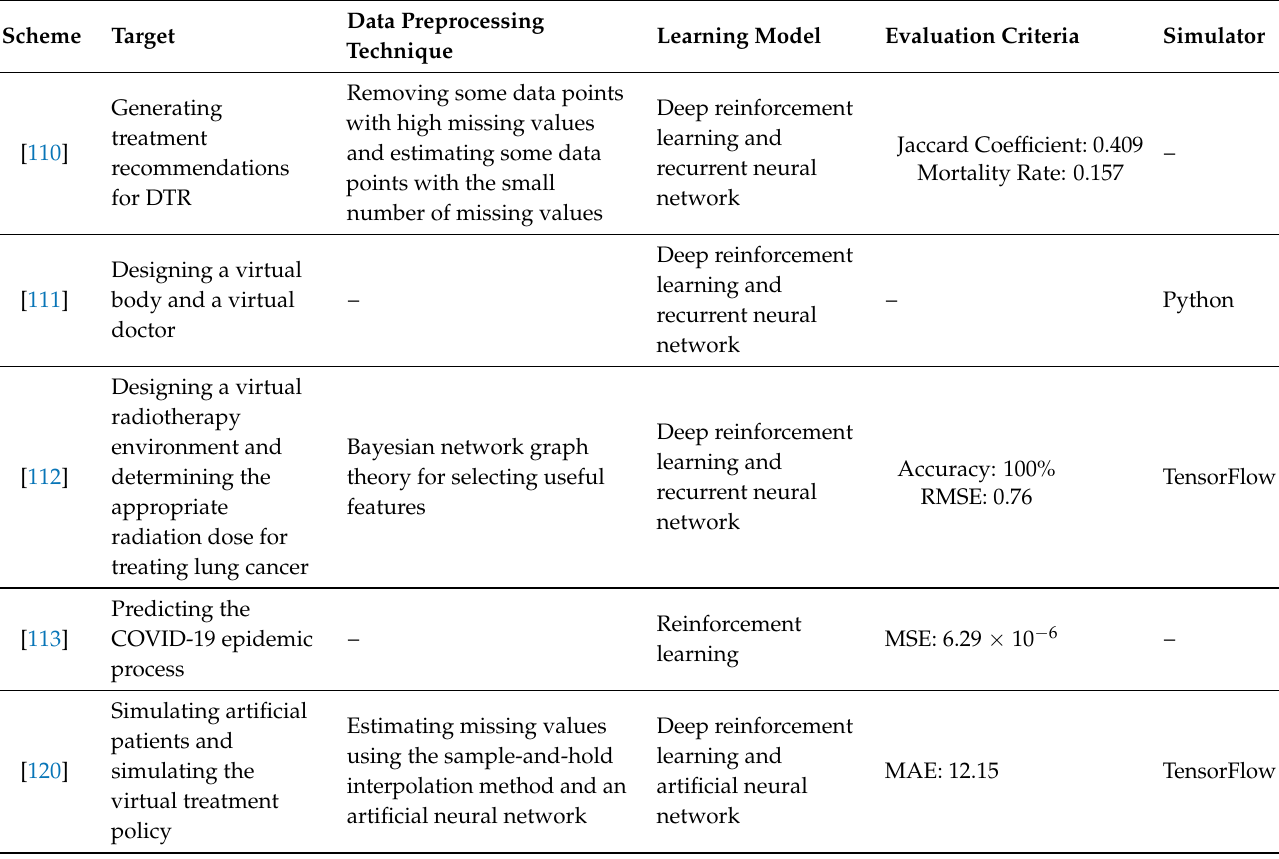
Table 10. The most important characteristics of reinforcement learning models.